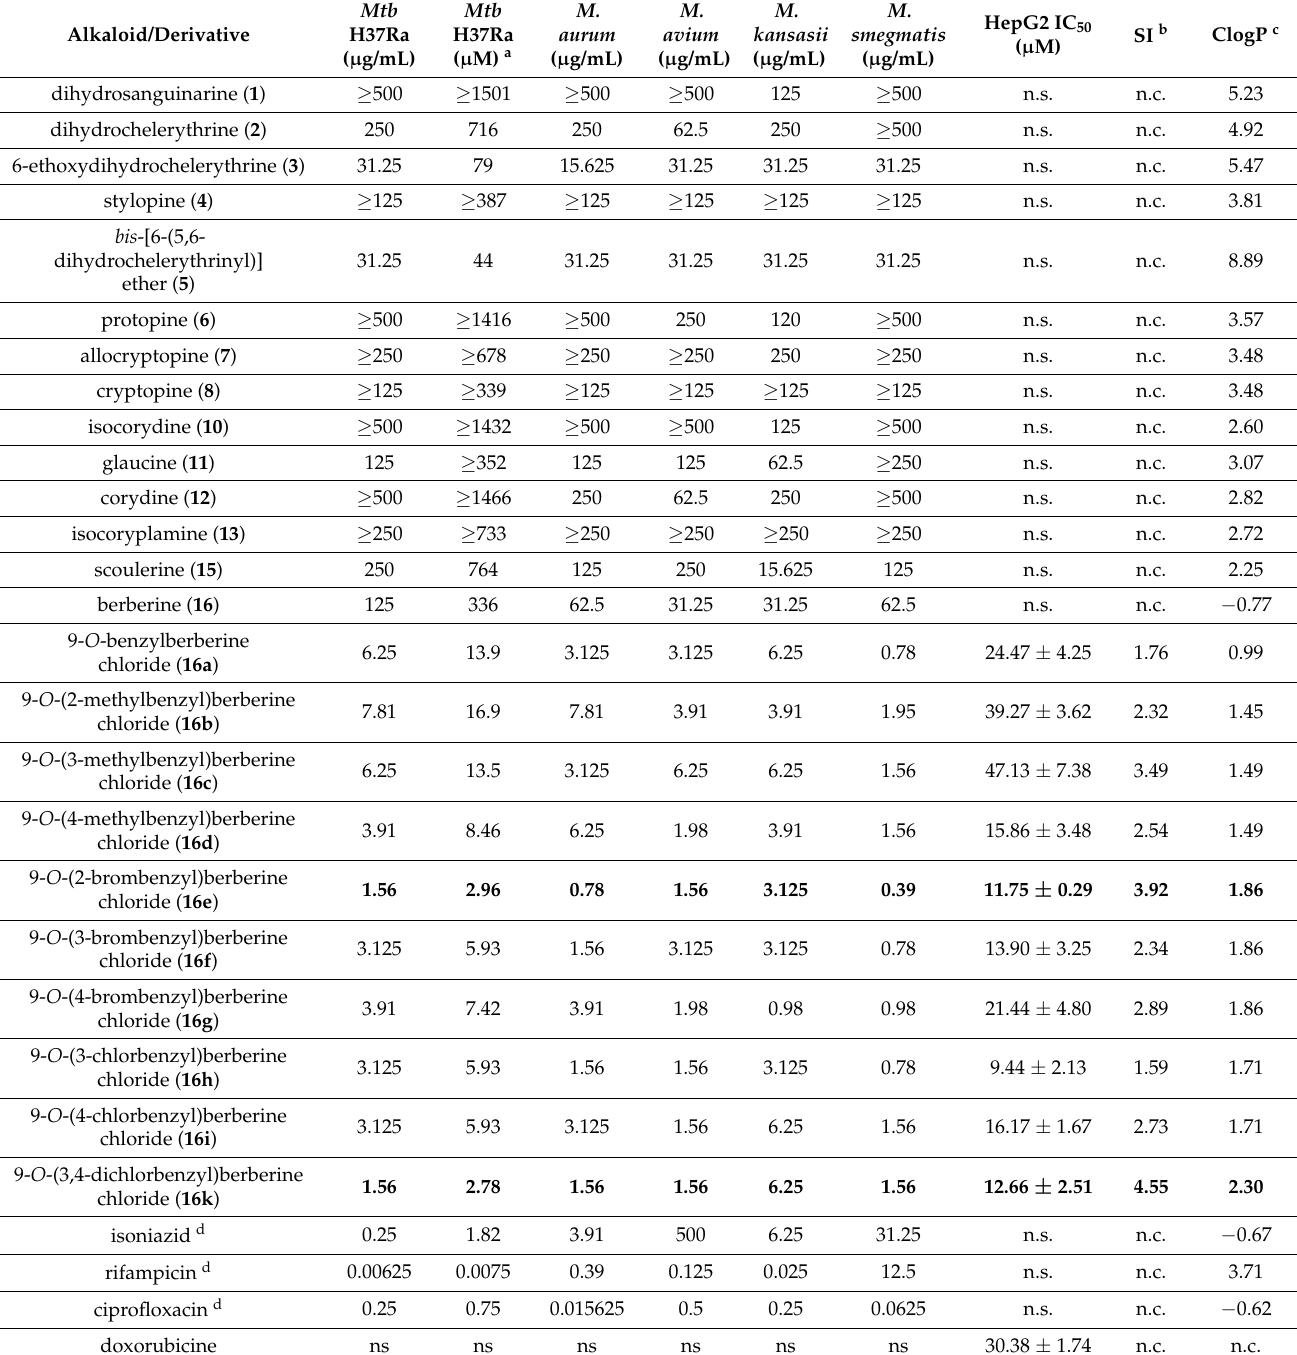
Table 1. In vitro antimycobacterial activity against Mtb H37Ra, Mycolicibacterium aurum , Mycobac- terium avium , Mycobacterium kansasii , and Mycolicibacterium smegmatis (MIC), cytotoxicity (IC 50 ), selectivity index (SI), and calculated lipophilicity (ClogP) of isoquinoline alkaloids and berber- ine